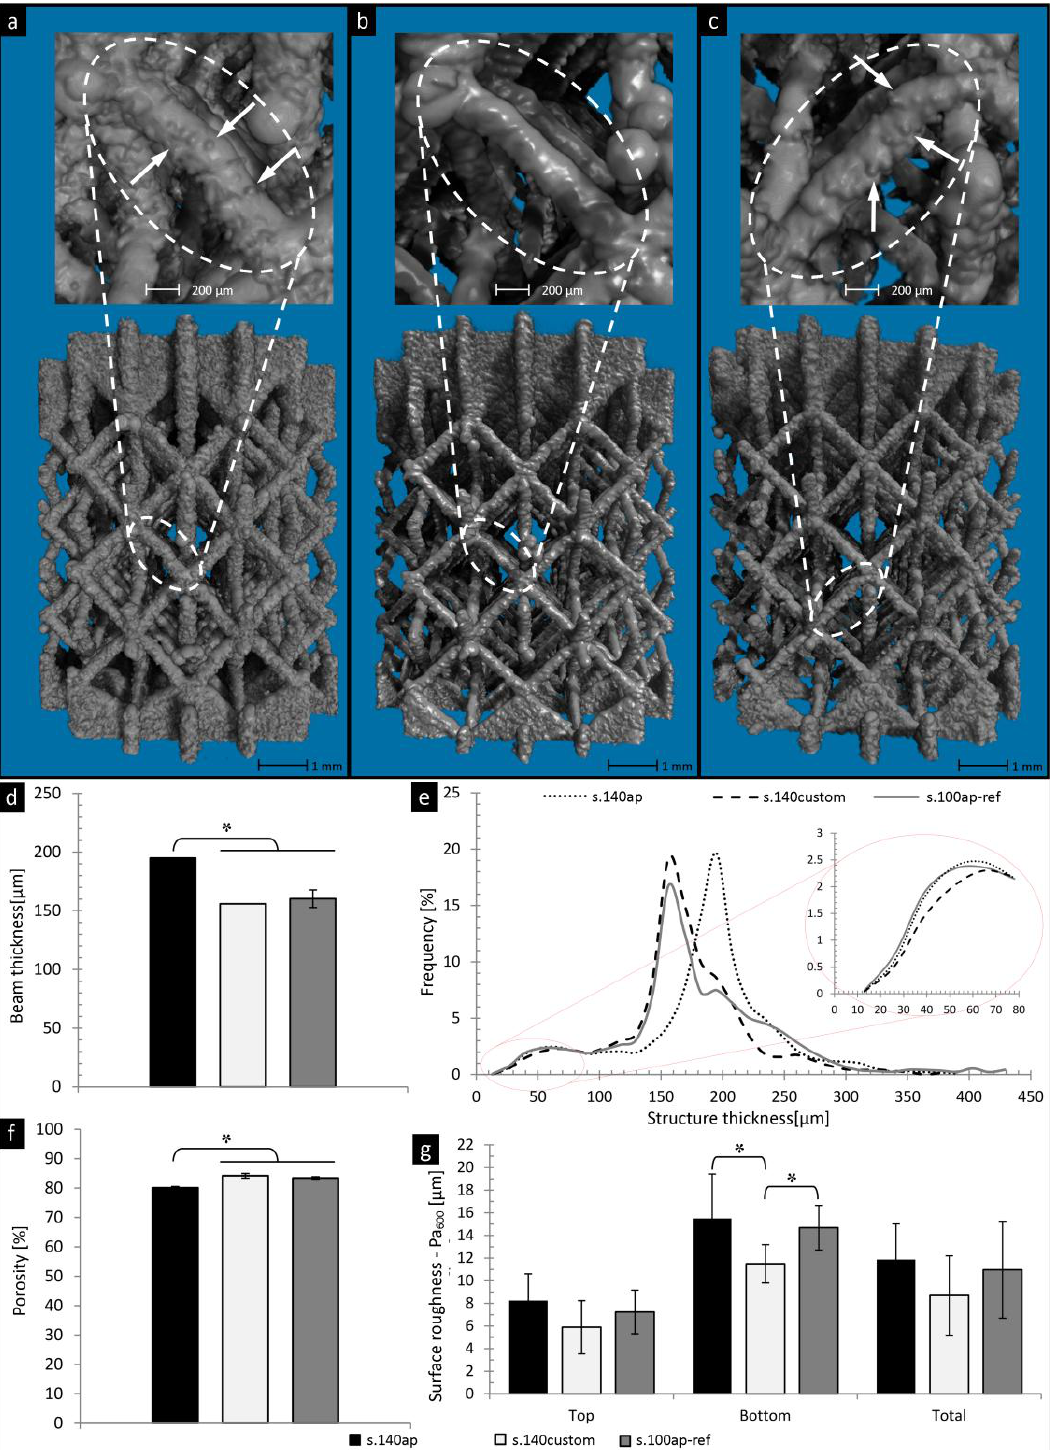
Figure 4. Micro-CT - based 3D visualization of the SLM-Ti6Al4V